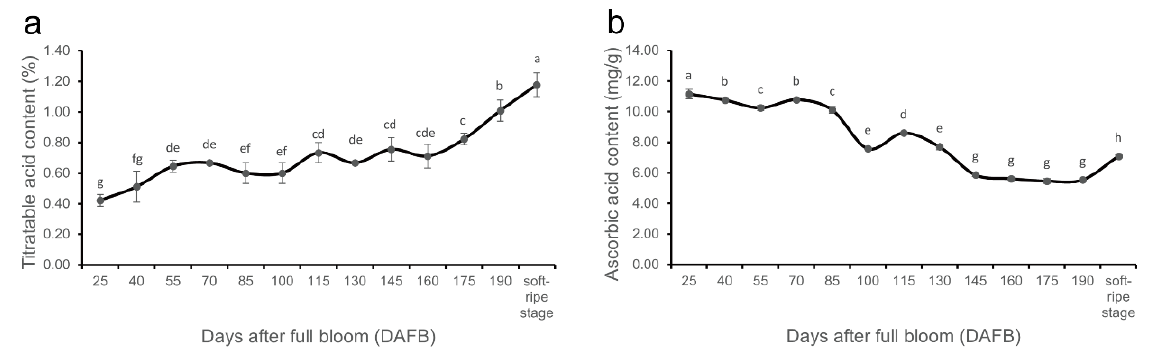
Figure 2. Dynamic changes of titratable acid content and ascorbic acid content during fruit devel- opment of A. eriantha ‘Ganlv 1’. ( a ) Changes of titratable acid content during fruit development of ‘Ganlv 1’; ( b ) Changes of ascorbic acid content during fruit development of ‘Ganlv 1’.